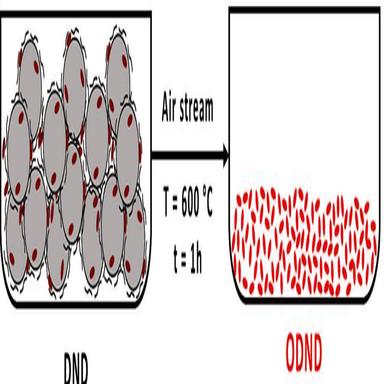
Selective combustion of the detonation nanodiamonds leading to the outcome ODND sample. DNDs are represented as grey solid circles surrounded by some graphite layers (in black) and inorganic impurities (in brown). The resulting ashes (ODND) are displayed in red. (For interpretation of the references to colour in this figure legend, the reader is referred to the web version of this article.)